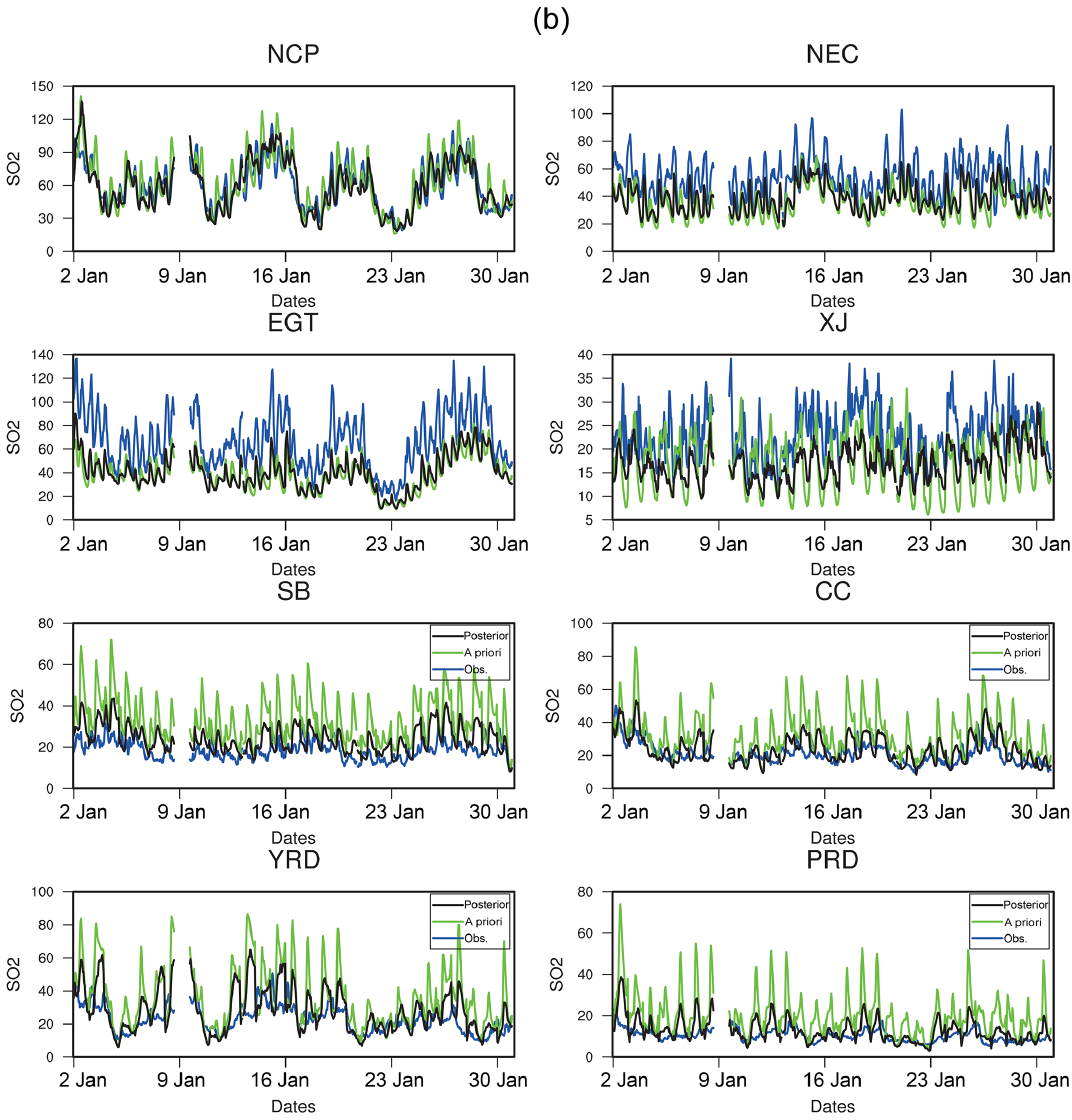
Figure 13. Time series of the regional mean SO 2 concentrations from the observations and from model simulations with the a priori and analyzed (posterior) emissions for (a) January 2015 and (b) January 2016 in eight regions. Time starts from 00:00UTC. (Units: µgm − 3